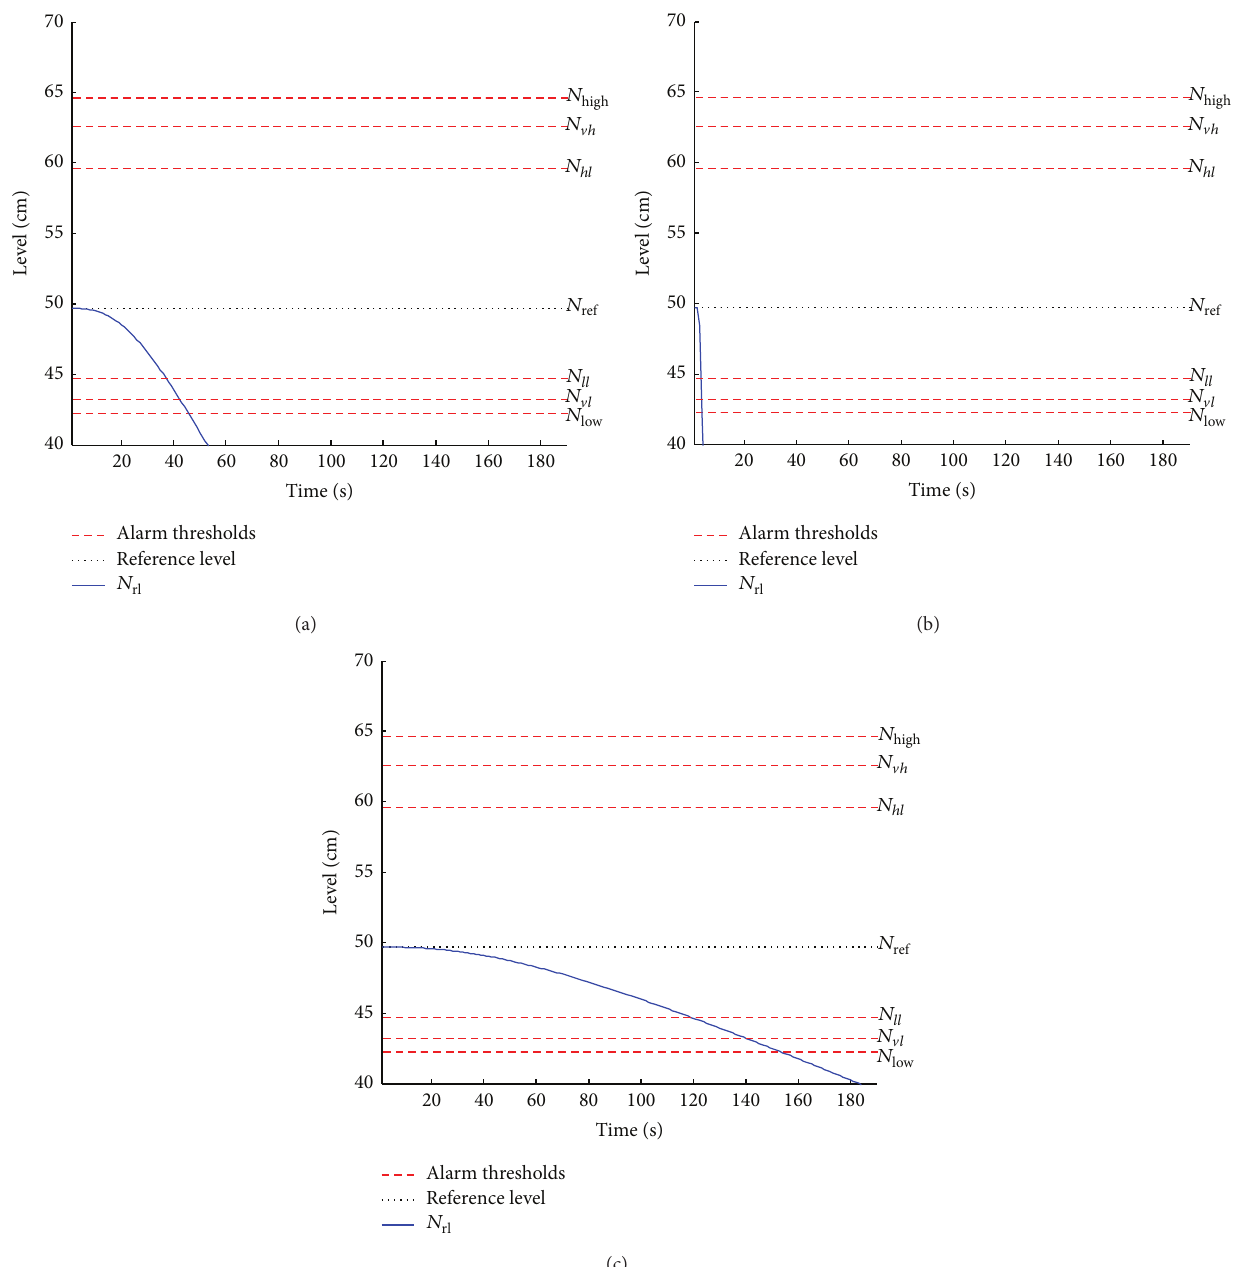
= 50.5 (kg/s); (b) the steam valve fails stuck closed; (c) the PID sf